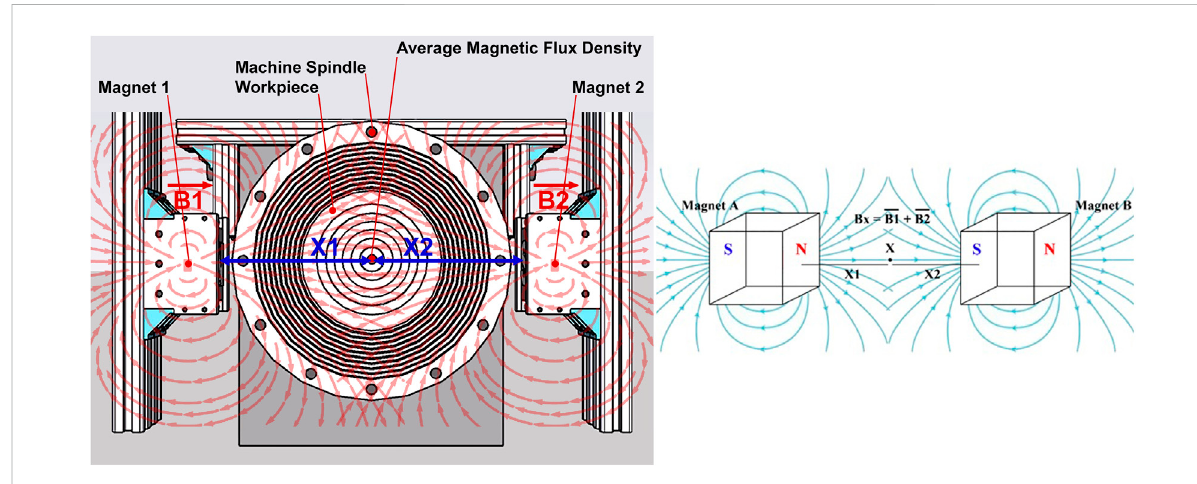
FIGURE 2 Illustration of the magnetic fl ux density generated between two magnets at the cutting